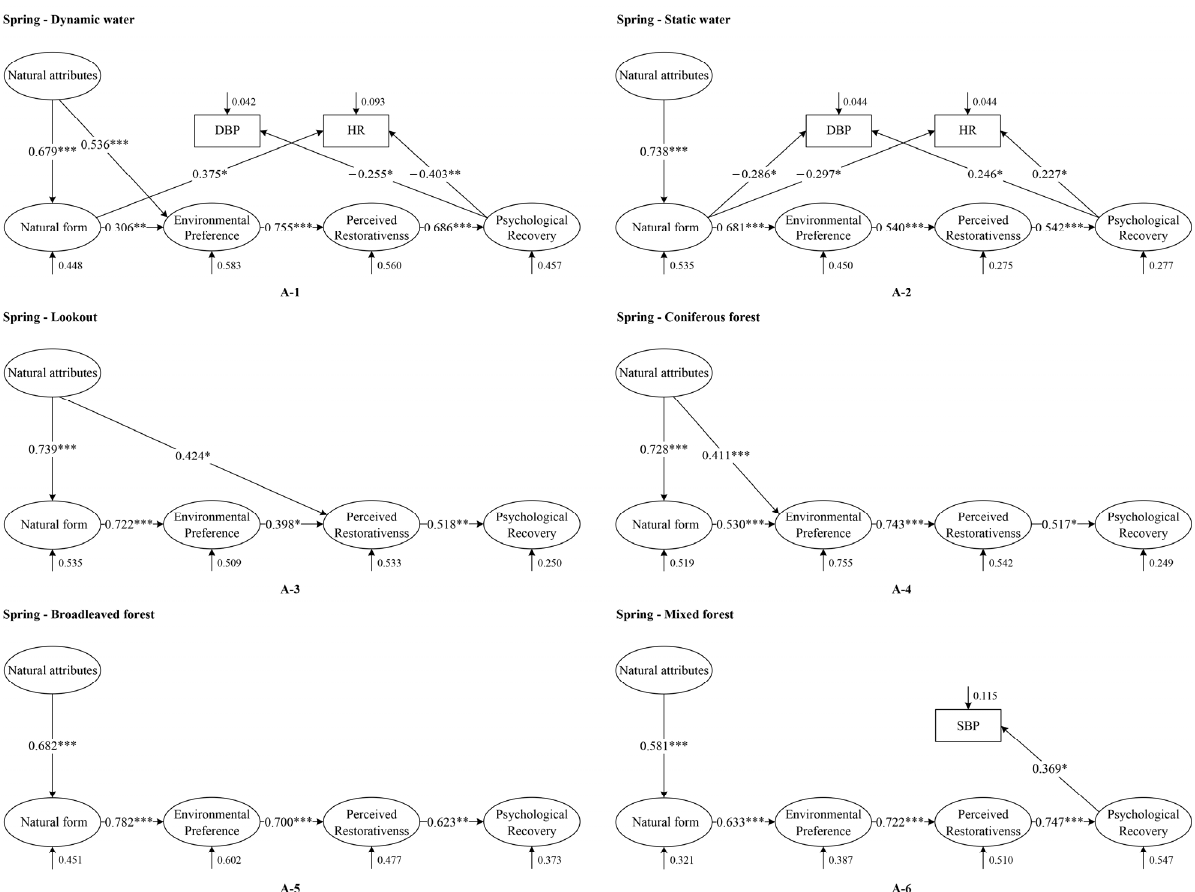
Figure A1. The relationship between landscape perception and physical and mental recovery in different spring spaces. ( A-1 ) Spring dynamic water landscape. ( A-2 ) Spring static water landscape. ( A-3 ) Spring lookout landscape. ( A-4 ) Spring coniferous forest landscape. ( A-5 ) Spring broadleaved forest landscape. ( A-6 ) Spring mixed forest landscape. * p < 0.05; ** p < 0.01; *** p < 0.001. SBP: systolic blood pressure; DBP: diastolic blood pressure; HR: heart rate. This figure was created by Rui